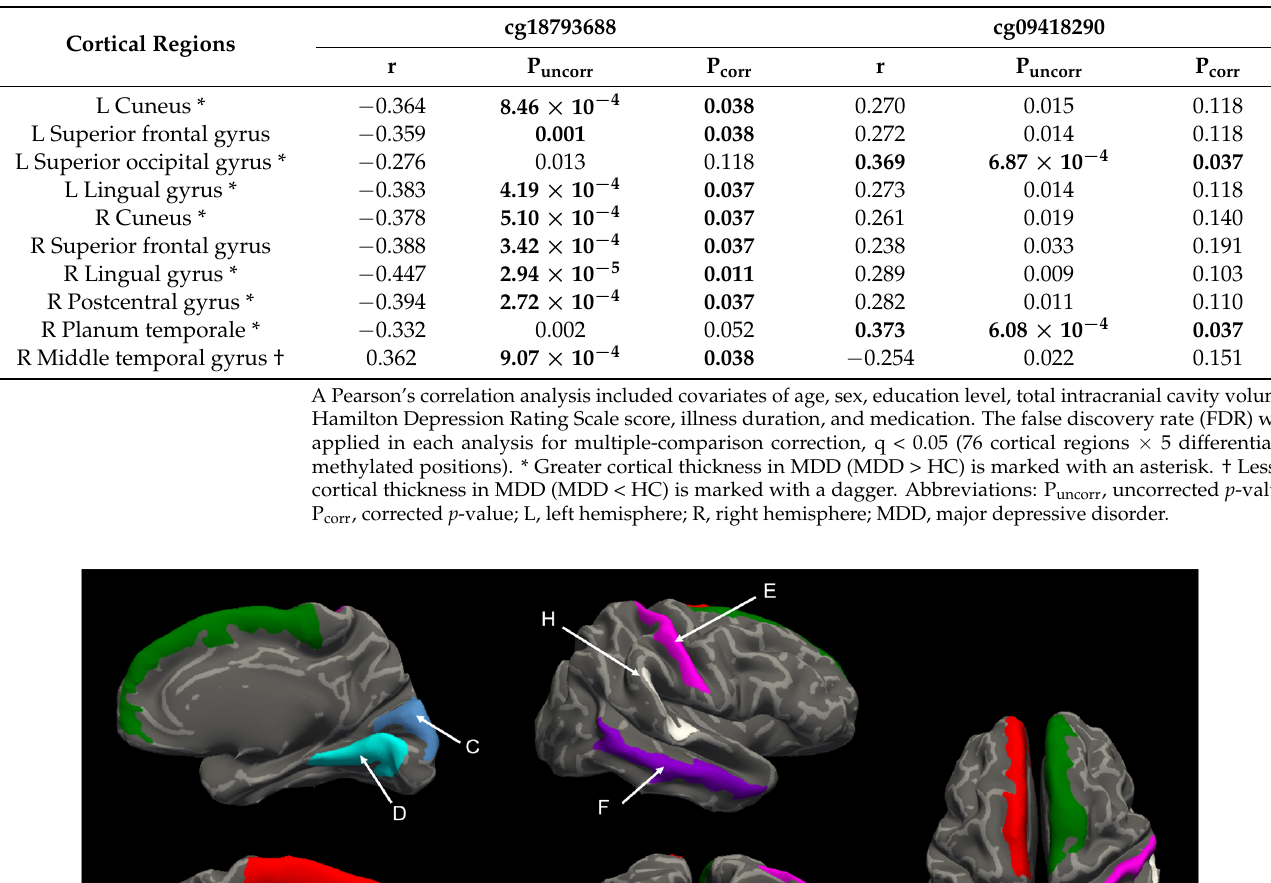
Table 4. Correlation between NLRP3 DNA methylation and cortical thickness in patients with MDD.